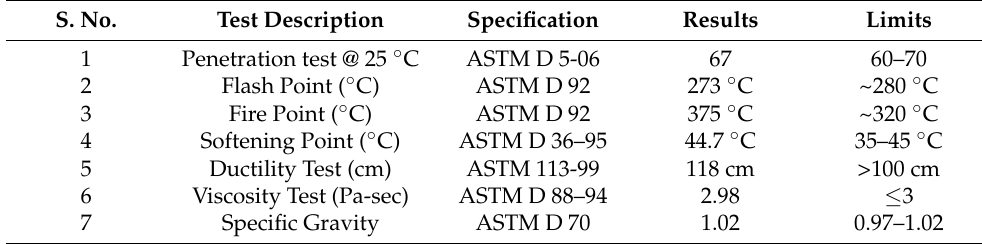
Table 3. Properties of base